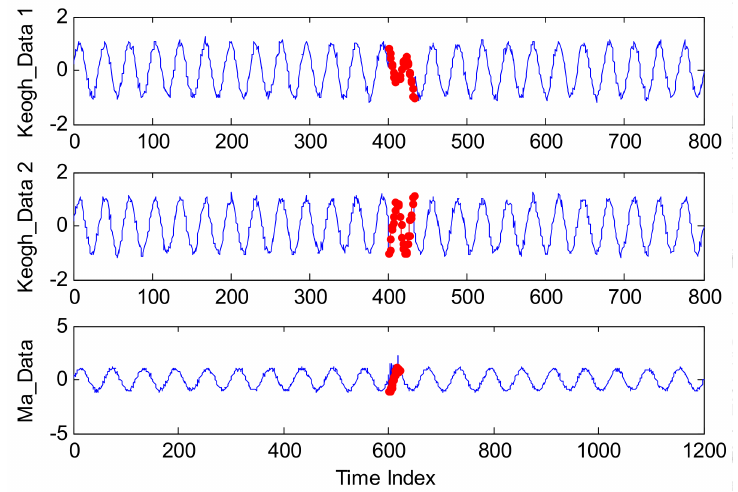
Figure 8. Time series of Keogh_Data 1, Keogh_Data 2, and